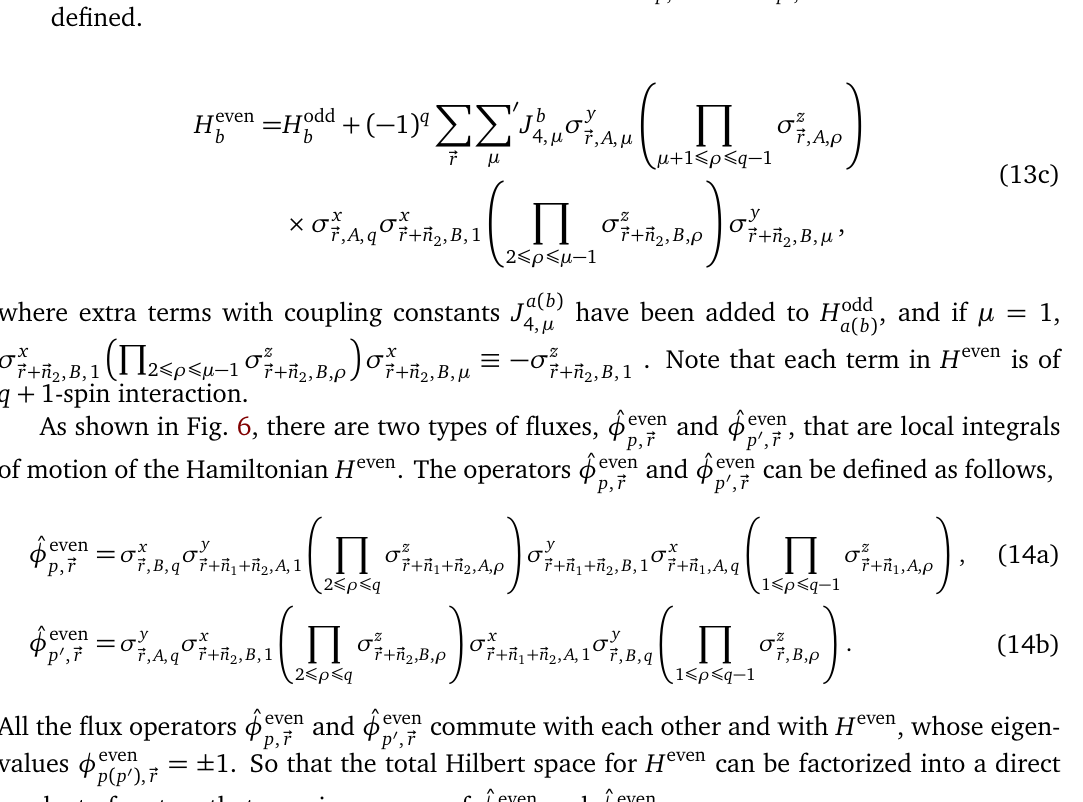
Figure 6: The plaquettes where the flux operators ˆ φ even